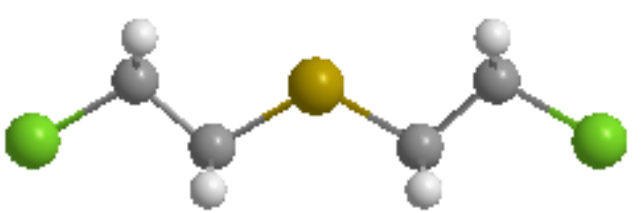
Figure 1. Bis-(2-chloroethyl)